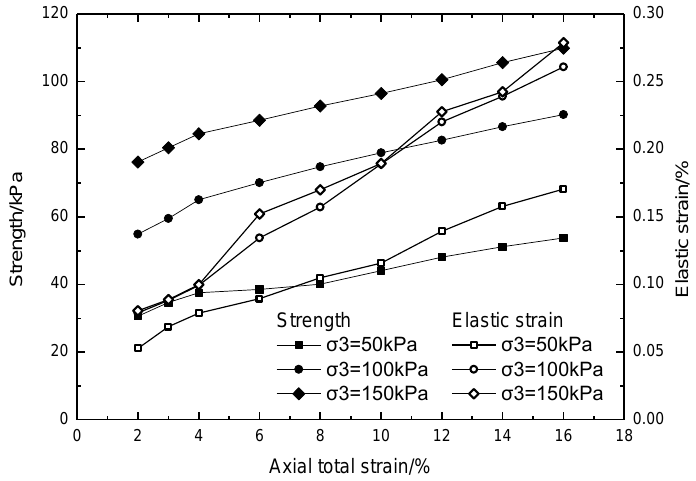
Figure 8. Strength and elastic strain corresponding to the resilient modulus.